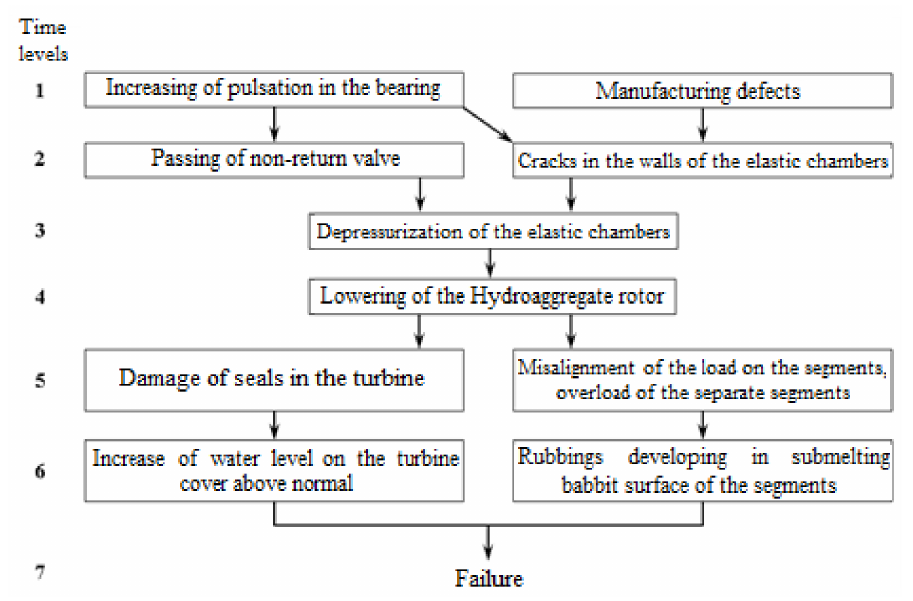
Figure 3. The Diagram of Defects Development of the Thrust Bearing